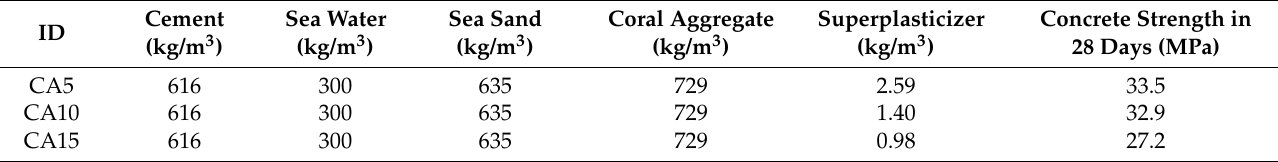
Table 5. Mixture proportions of